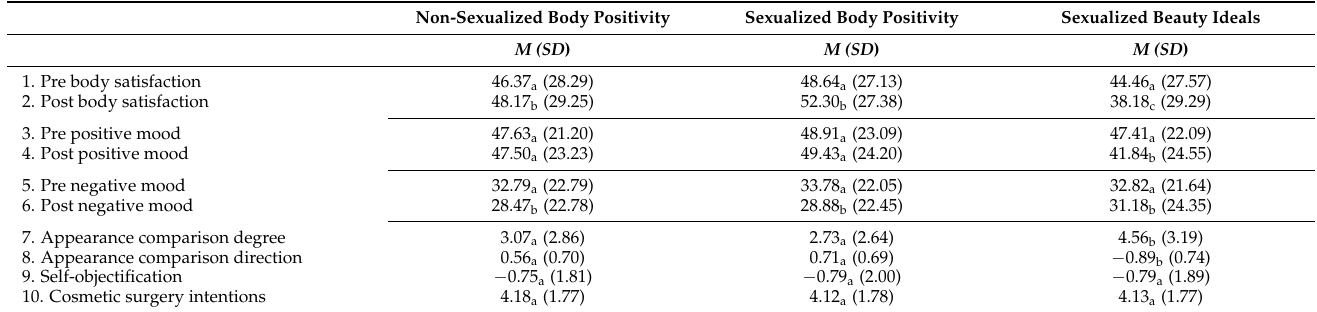
Table 4. Descriptive Statistics (Means and Standard Deviations) of Joynt Analyses’ Dependent Variables Separated for